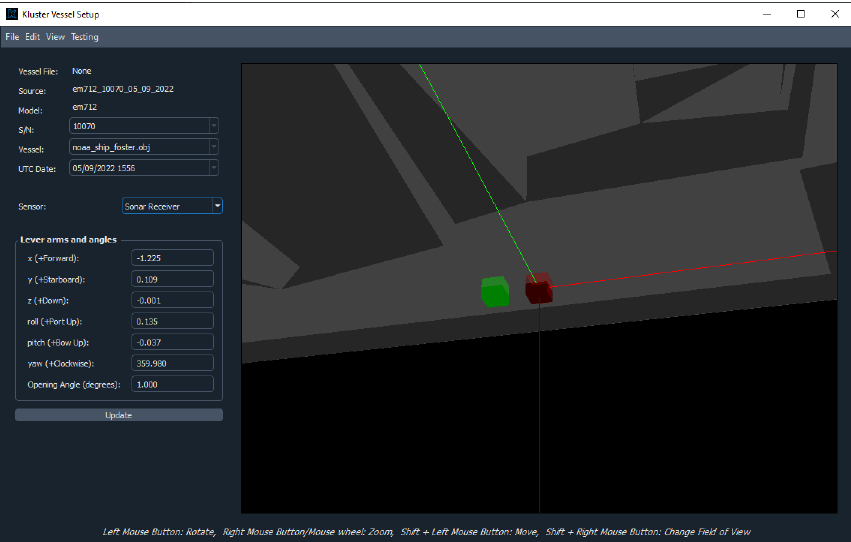
Figure 5. Vessel Setup utility showing the sonar transmitter (red) and receiver